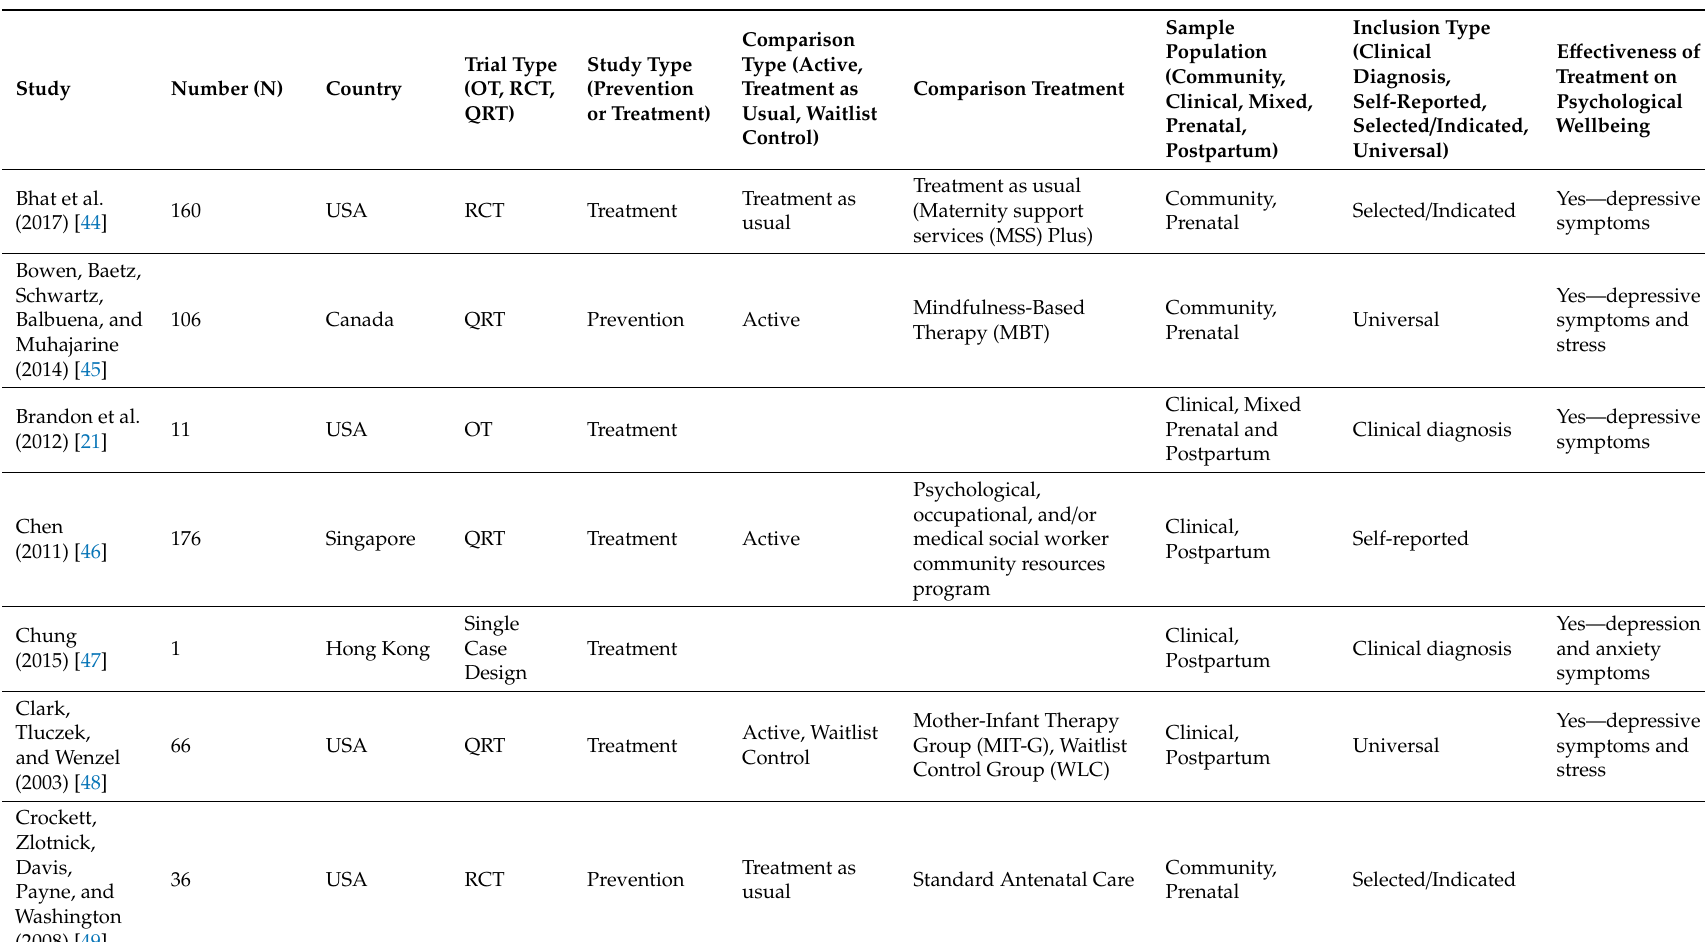
Table 1. Characteristics of Included